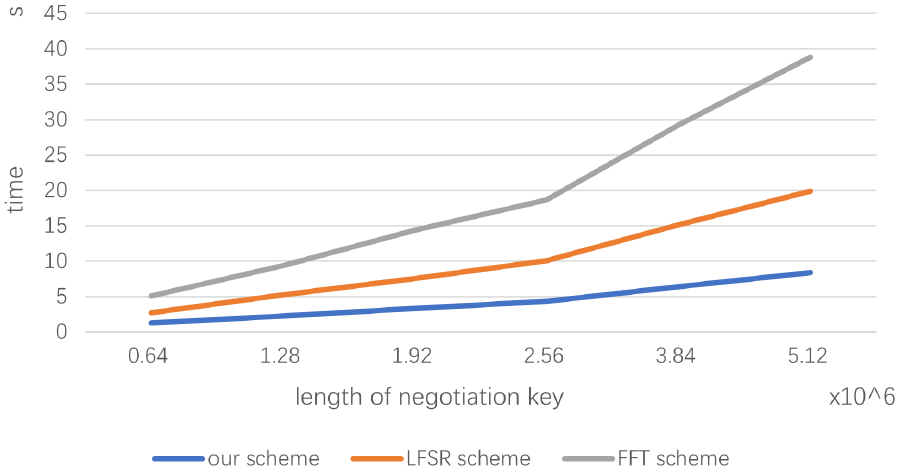
Figure 4. Final key generation rate comparison of LFSR scheme [18], FFT scheme [12] and proposed scheme when N / M = 0.1.